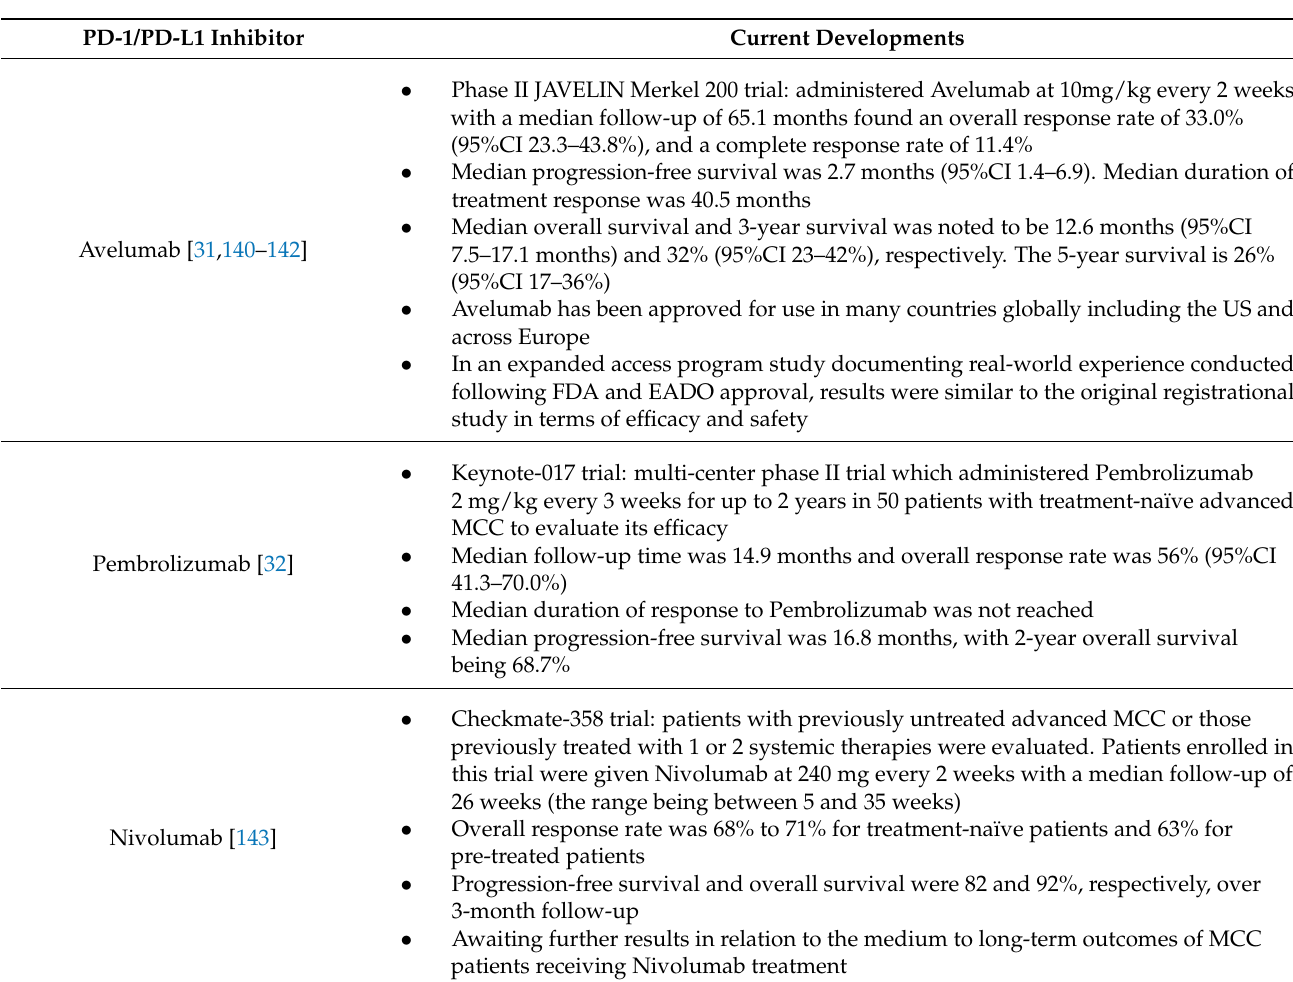
Table 2. Current developments of utilizing Avelumab, Pembrolizumab and Nivolumab for treatment of